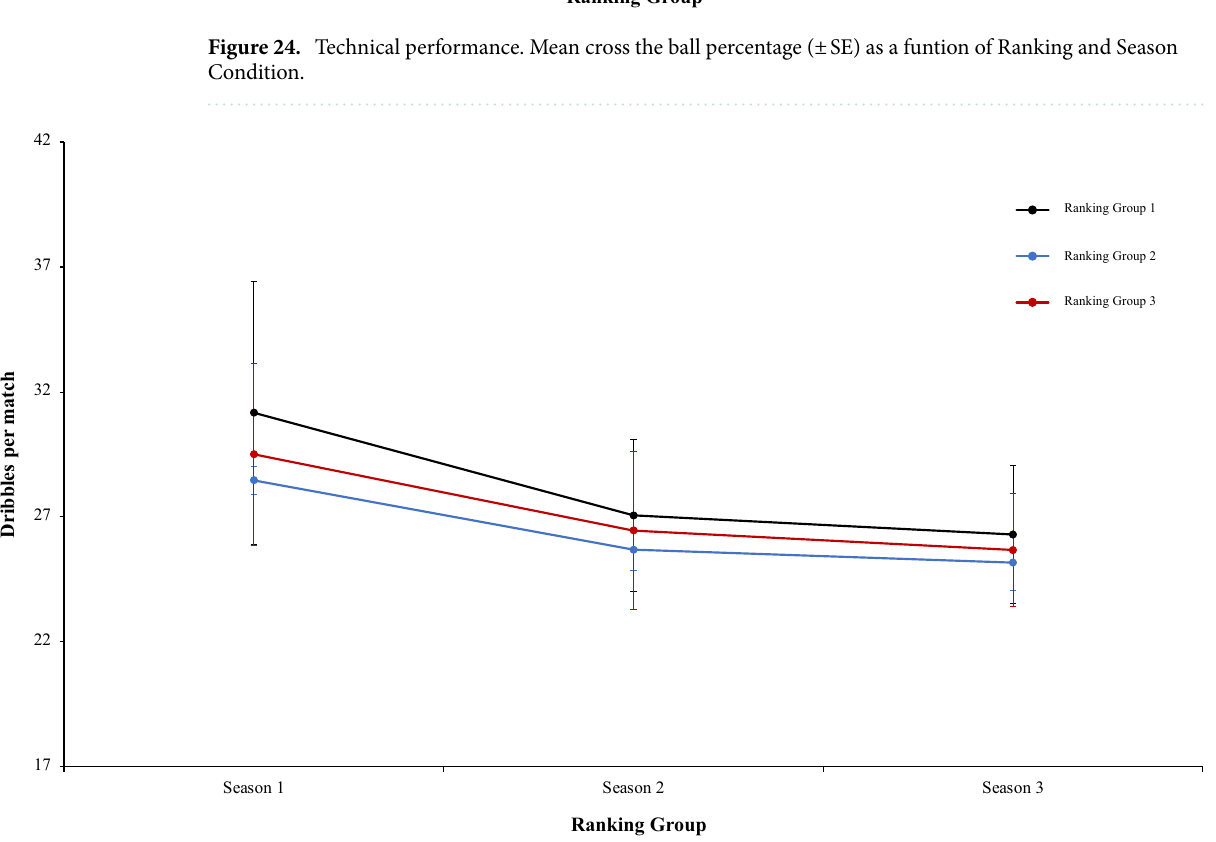
Figure 25. Technical performance. Mean dribbling per match (± SE) as a funtion of Group and Season